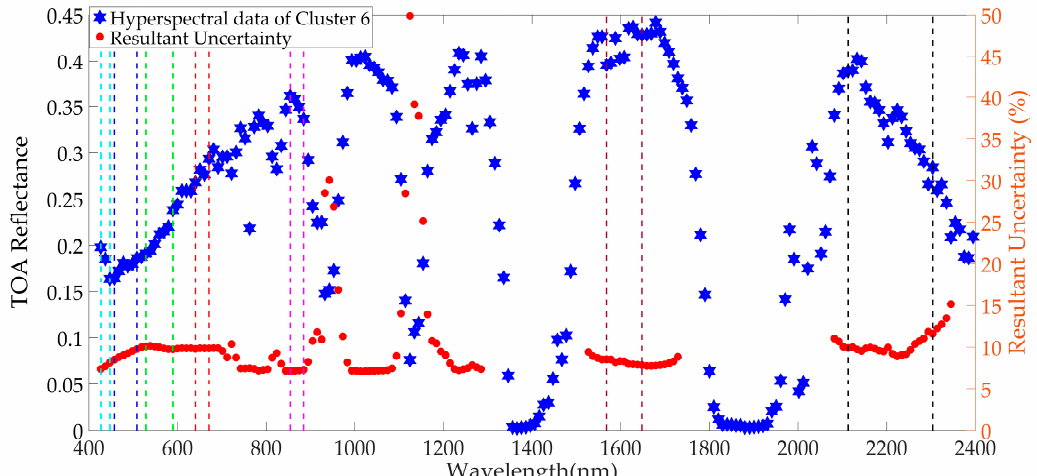
Figure A3. Estimated representative hyperspectral profile of Cluster 5 and its resultant uncertainty.